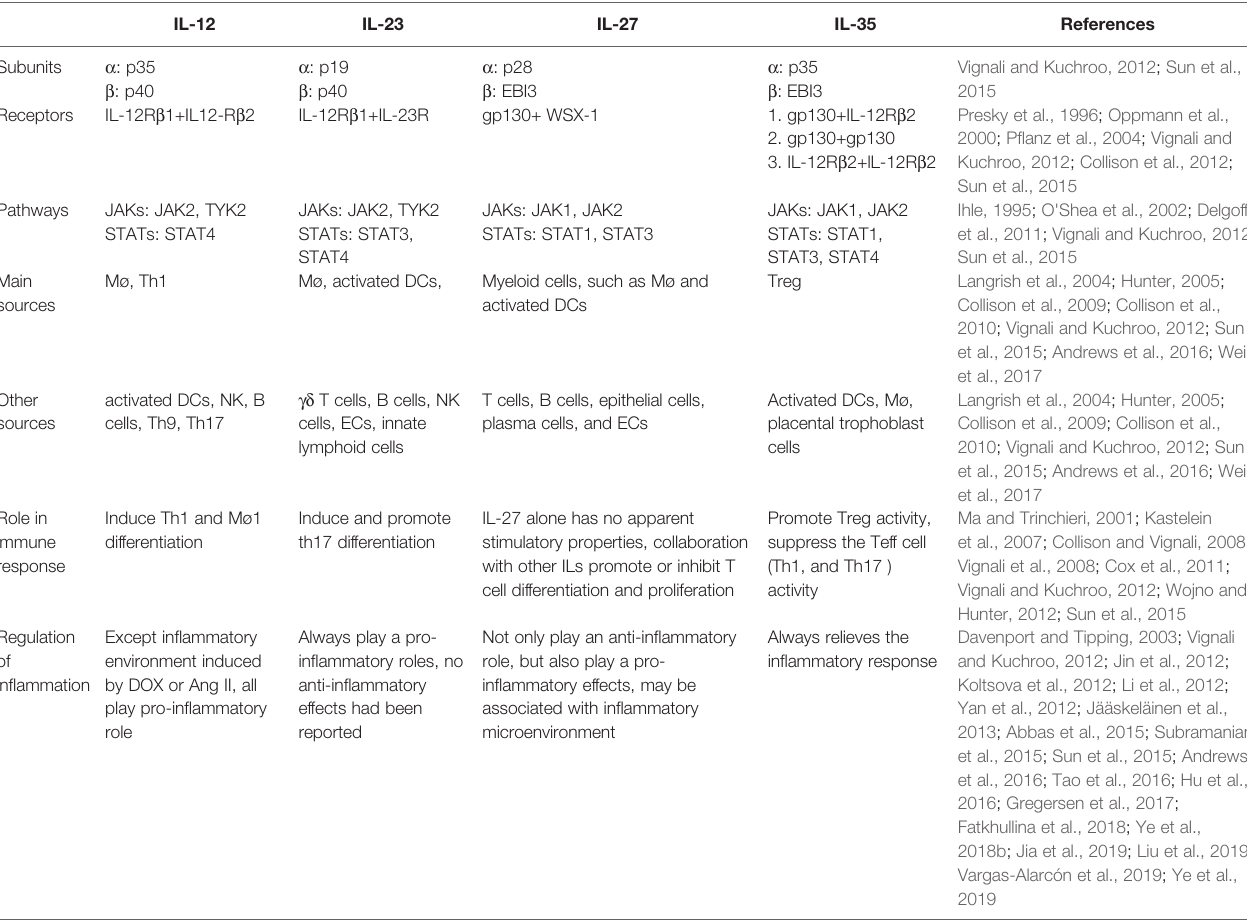
TABLE 1 | The subunits, receptors, signaling pathways of the IL-12 family